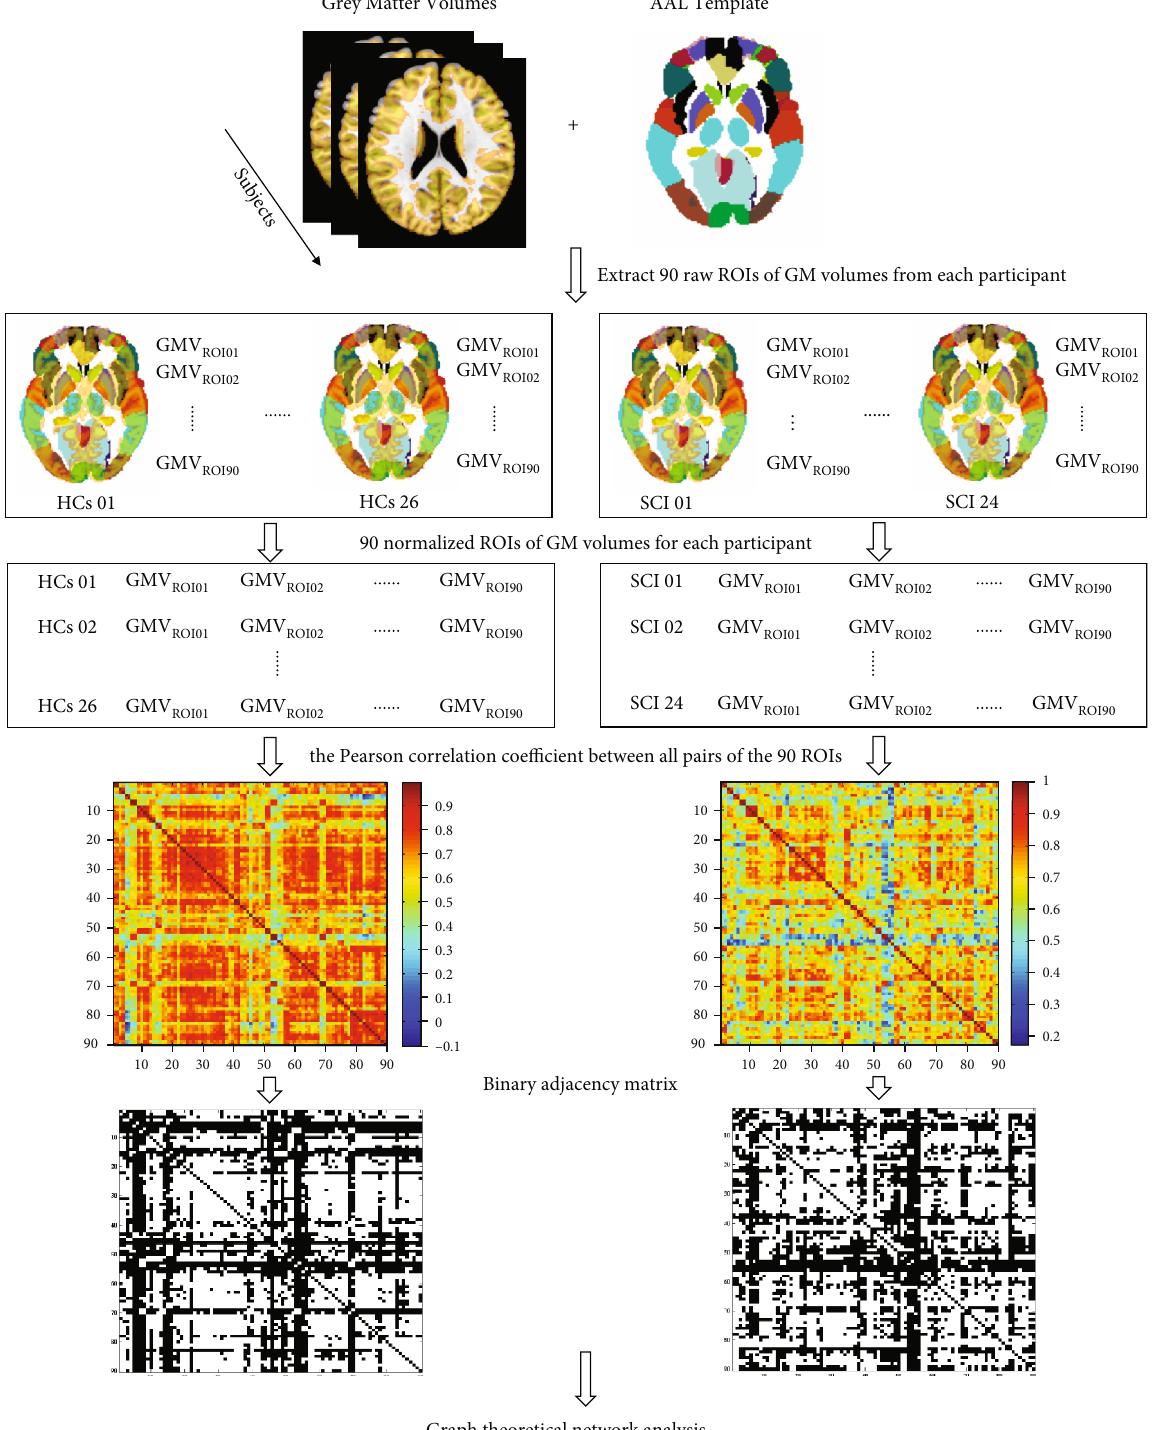
Figure 1: The diagram of structural covariance network construction and analysis. AAL: anatomical automatic labeling; GMV: grey matter volume: ROI: region of interest; HCs: healthy controls; SCI: spinal cord